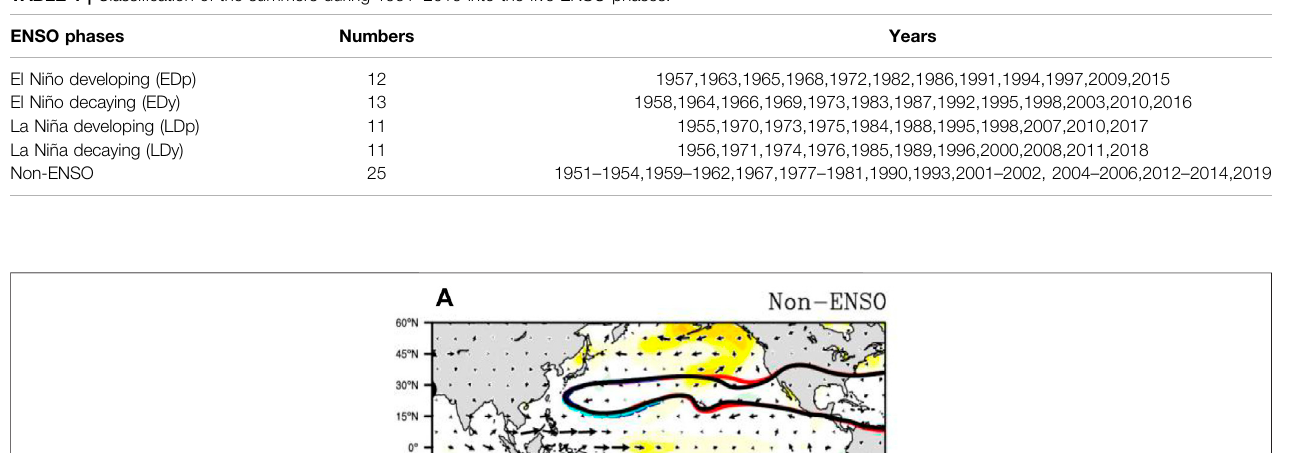
Frontiers in Earth Science |